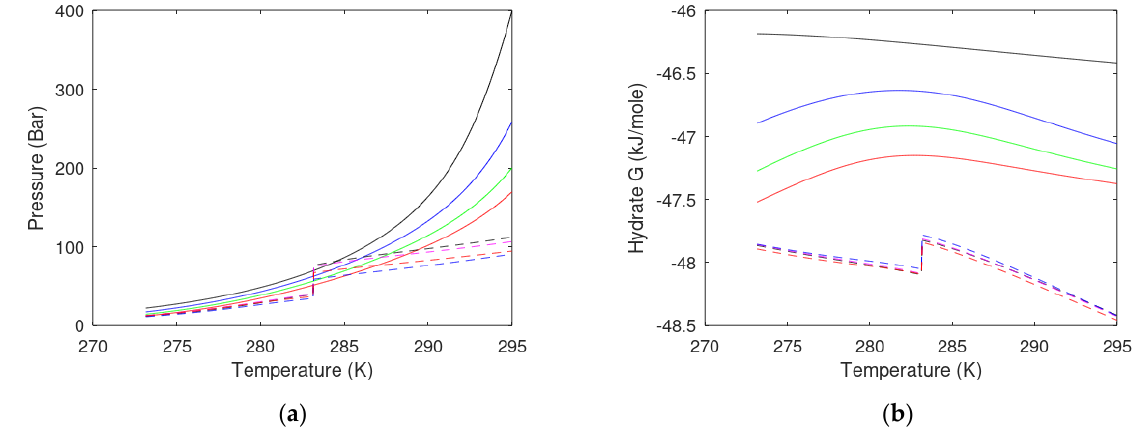
Figure 11. ( a ) Calculated pressure temperature stability limits for hydrates formed from pure CH 4 (black), from 99 mole% CH 4 and 1 mole% H 2 S (blue), from 99 mole% CH 4 and 2 mole% H 2 S (green), and from 99 mole% CH 4 and 3 mole% H 2 S (red). Dashed curves are for different compositions of injection gas. Black is for a mixture of 80 % CO 2 , 10% CH 4 , and 10% N 2 . Magenta is for a mixture of 75 % CO 2 , 10% CH 4 , and 15% N 2 . Blue is for 70% CO 2 , 5% CH 4 , 5% C 2 H 6 , and 20% N 2 . Red is for 70% CO 2 , 5% CH 4 , 2% C 2 H 6 , and 23% N 2 . ( b ) Molar Gibbs free energy for hydrate from pure CH 4 and the 3 mixtures of CH 4 with H 2 S. Same color codes as in Figure 11 (a).